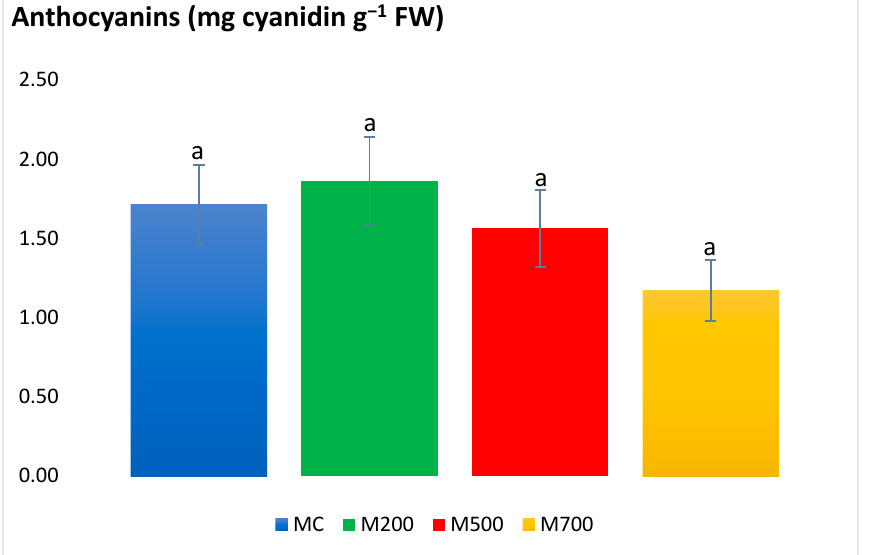
Figure 8. Concentration of anthocyanins in the leaves of Mis-B cultivar cultivated in soils with gradient T.E. concentrations (MC, M200, M500, M700). Values are presented as mean ± SE. Different le tt ers refer to signi fi cant di ff erences between plants (Tukey HSD test, n = 6, p ≤ 0.05). Tannin concentration (Figure 9) showed a particular di ff erence between M200 (90.97 ± 3.48 mg L − 1 catechin g − 1 FW) and M700 (116.21 ± 9.11 mg L − 1 catechin g − 1 FW) with a 22% augmentation. Otherwise, no signi fi cant variations were detected between treatments.